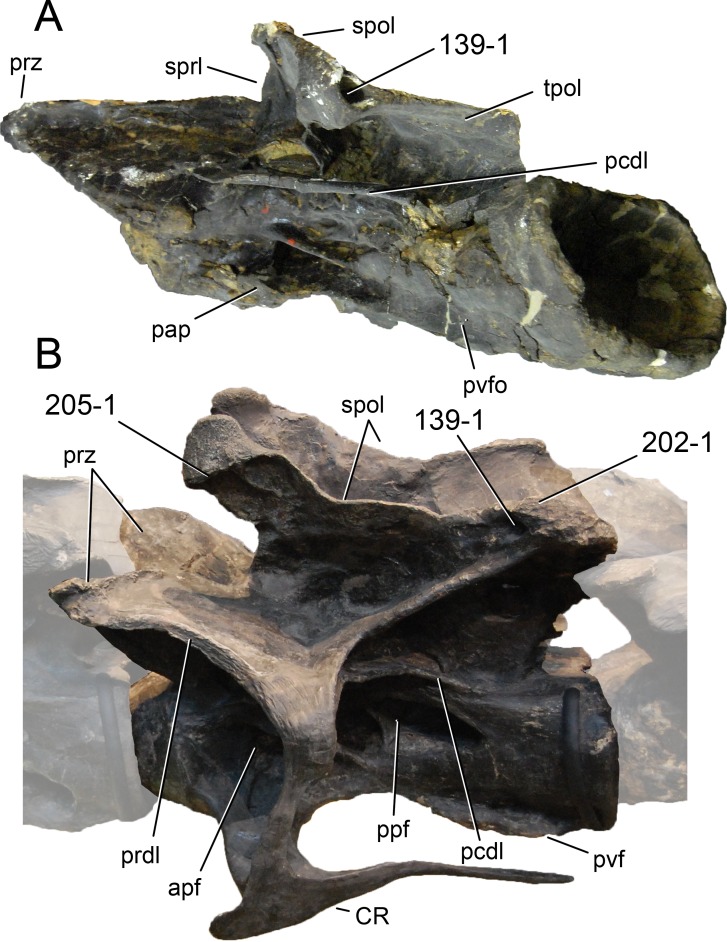
Diplodocine mid- to posterior cervical vertebrae.Mid- to posterior cervical vertebrae of Barosaurus lentus YPM 429 (A) and Diplodocus carnegii CM 84 (B) in left posterolateral (A) and left dorsolateral view (B). Note the differently pneumatized epipophyses (C139-1), the transversely compressed epipophysis (B; C202-1), and the horizontal ridge below the neural spine summit in Diplodocus (B; C205-1). The cervical vertebra of B. lentus is partly covered by matrix and plaster. Abb.: apf, anterior pneumatic fossa; CR, cervical rib; pap, parapophysis; pcdl, posterior centrodiapophyseal lamina; ppf, posterior pneumatic fossa; prdl, prezygodiapophyseal lamina; prz, prezygapophysis; pvf, posteroventral flange; pvfo, posteroventral fossa; spol, spinopostzygapophyseal lamina; sprl, spinoprezygapophyseal lamina. Vertebrae scaled to the same posterior cotyle height.